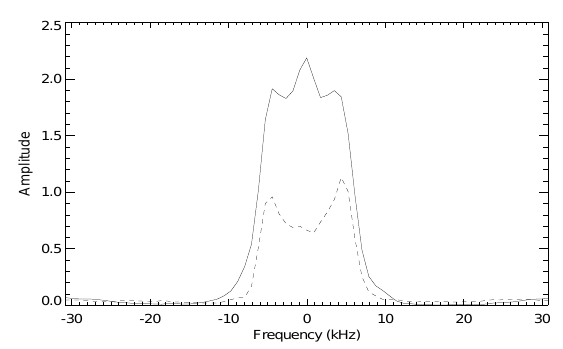
Fig. 10. Comparison of average ion spectra for SPEAR on with that for SPEAR off at 4.9MHz for 12:04–12:12 UT, 27 April 2004.